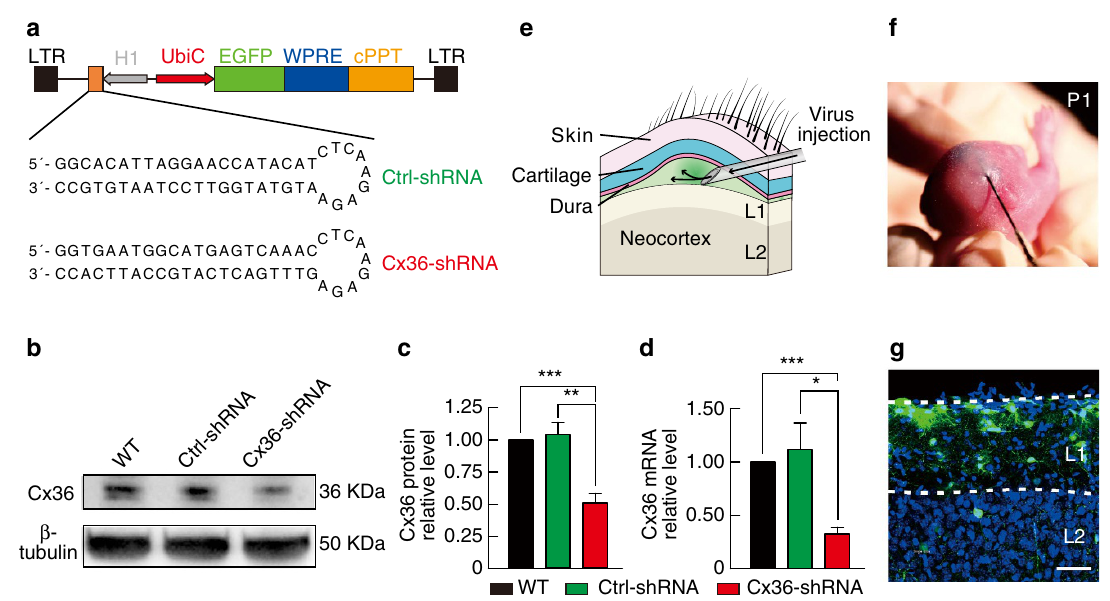
Figure 6 | Inducible lentiviral shRNA mediates effective knockdown of Connexin 36. ( a ) Schematic illustration of the shRNA-expressing lentiviral constructs. The Ctrl-shRNA and the Cx36-shRNA inserts contained 21-nt sense and antisense strands. Sense and antisense strands were linked through a standard 5 0 -CTCAAGAGA-3 0 loop structure specific to mammalian cells. ( b ) Western blot of protein samples isolated from cultured E18 mouse primary cortical neurons infected with Ctrl-shRNA and Cx36-shRNA lentiviruses or WT cells (uninfected cells) and probed with anti-Cx36 and anti- b -tubulin antiserum. b -Tubulin served as a loading control ( n ¼ 4 pregnant mice). ( c , d ) Quantitative analysis of western blot ( c ) and real-time PCR ( d ) showed that both the protein ( B 50%) and mRNA levels ( B 68%) of Cx36 were significantly reduced in Cx36-shRNA-transfected cells as compared with WTcells and Ctrl-shRNA-transfected cells; no significant difference was noted between WT and Ctrl-shRNA groups ( P 4 0.05). Cx36 mRNA expression levels normalized for GAPDH . ( e ) Schema showing the method of virus injection, using a tiny self-made glass injector to inject the virus into the gap between the dura and cortical layer 1 at P1 with CD-1 mice (also see Methods). ( f ) Image of virus injection into neocortical layer 1 at P1. The fast green injected along with virus helped in estimating the extent of diffusion of the virus in neocortical layer 1. ( g ) Representative distribution of lentivirus-labelled GFP-positive (GFP þ ) cells. GFP þ cells densely packed in neocortical layer 1, but sparsely distributed in deep layers, were detected at P15. Scale bar, 50 m m. * P o